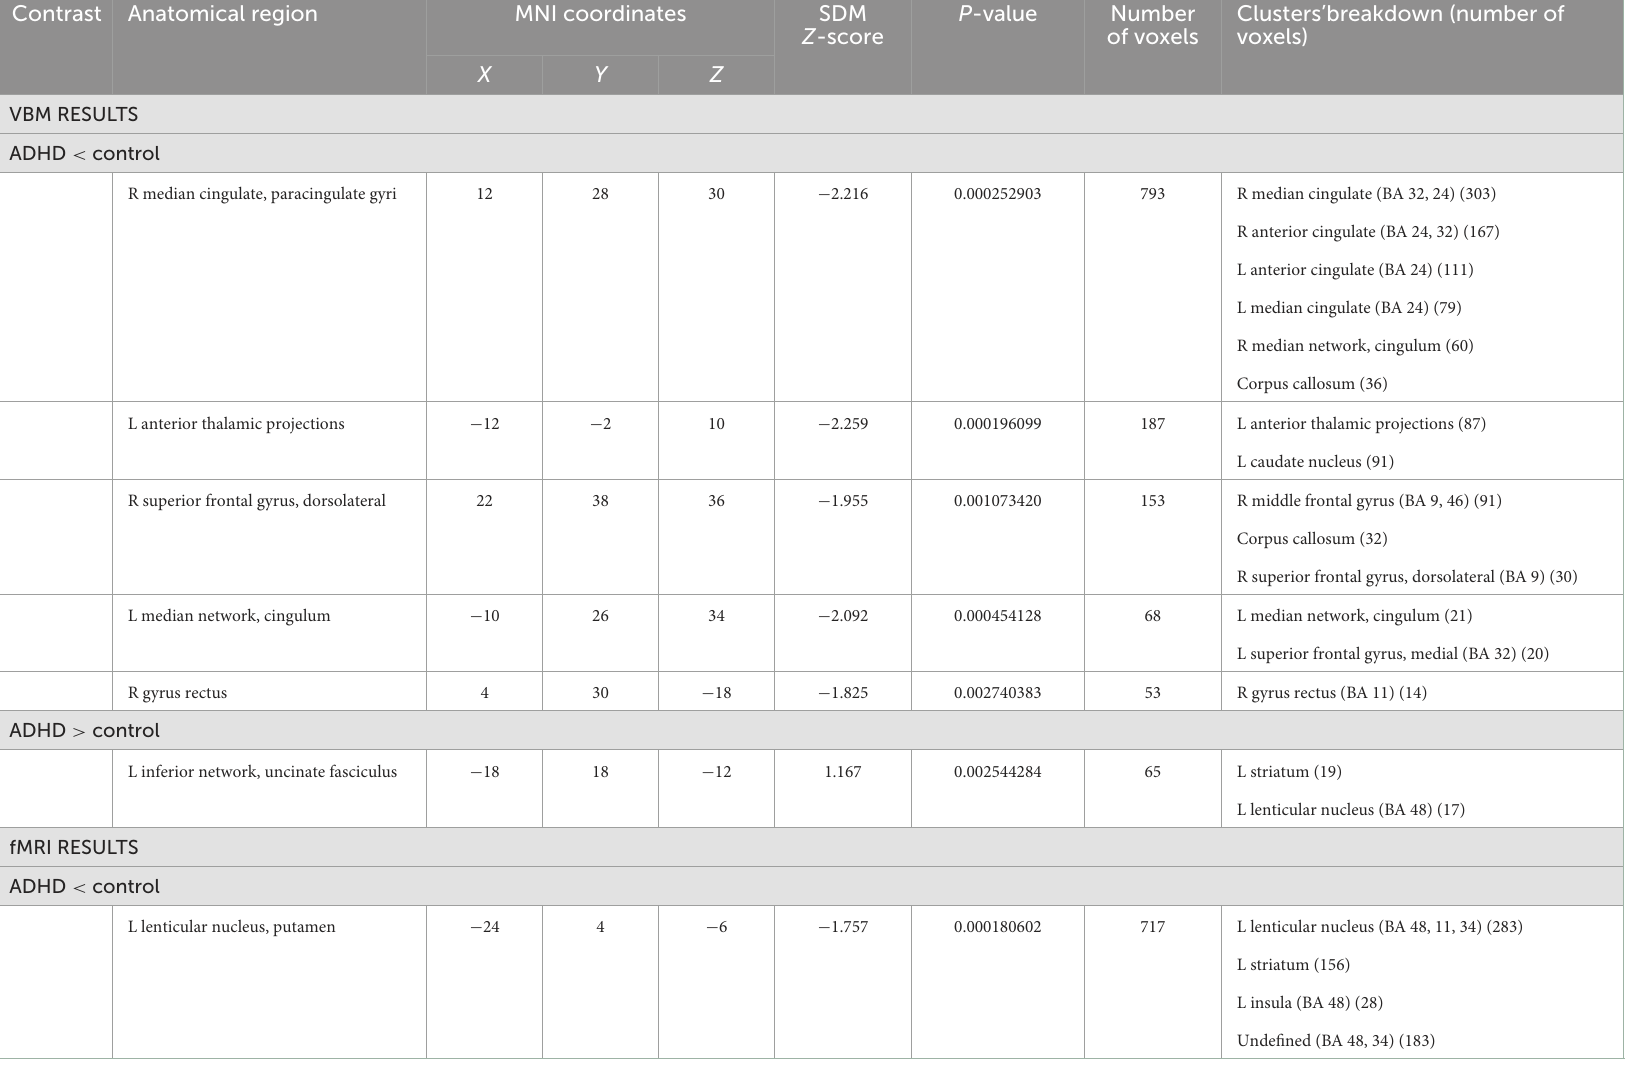
P -value Number Clusters’breakdown (number of Z -score of voxels voxels) X Y